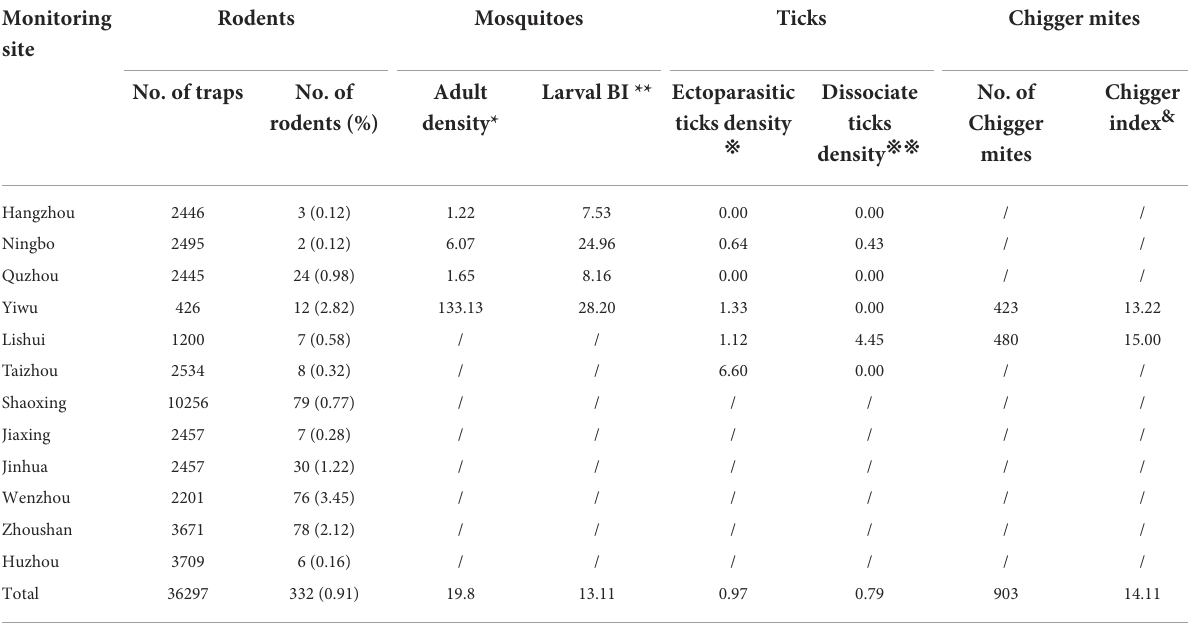
TABLE 3 Arthropod vectors and reservoir hosts collected in different monitoring sites in 2020 in Zhejiang Province, China.